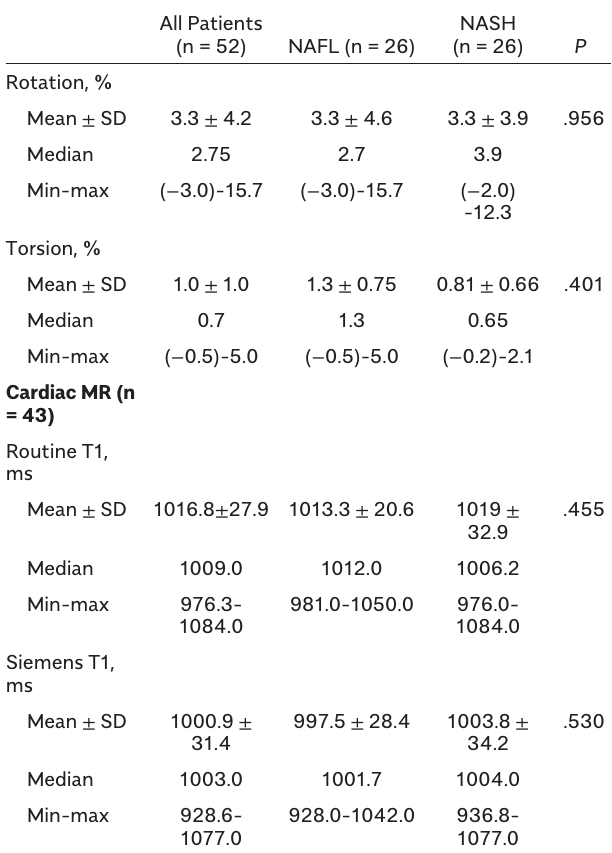
Table 4. Echocardiography and Cardiac MR Assessments of Patients ( Continued ) All Patients (n =